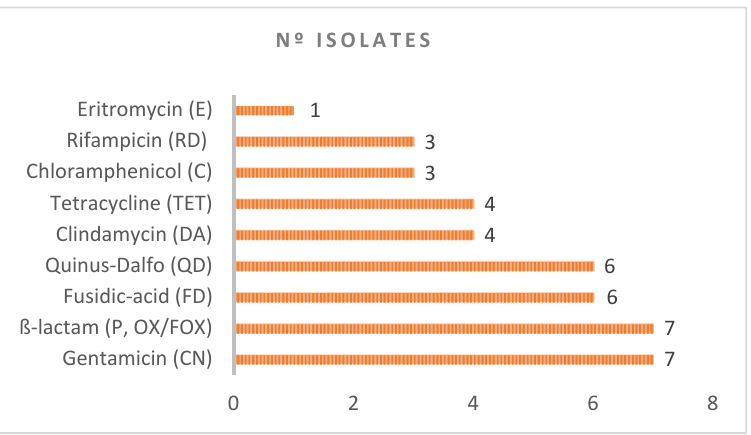
Figure 1. Antimicrobial resistance associated with the methicillin-resistant isolates.